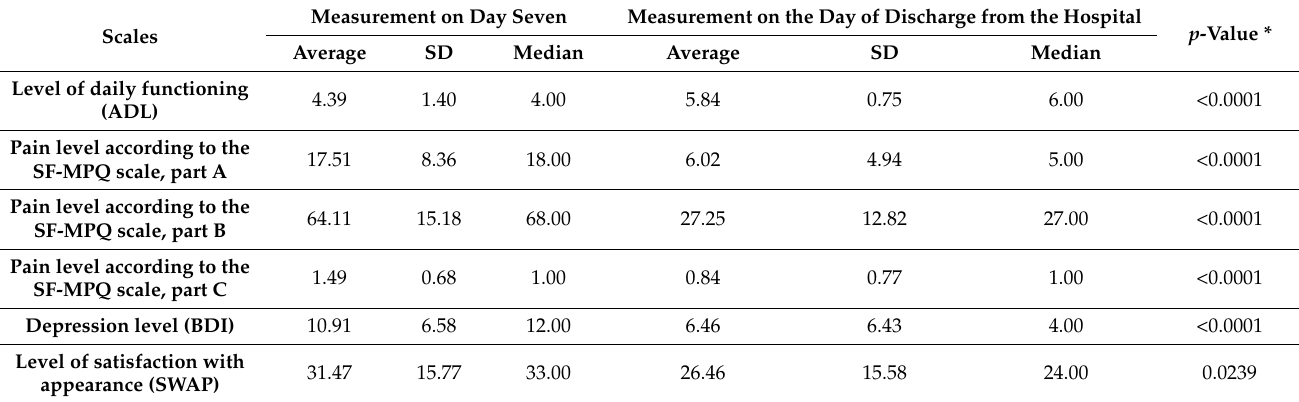
Table 2. Comparison of functioning and subjects on day seven of hospitalisation and the day of discharge from the